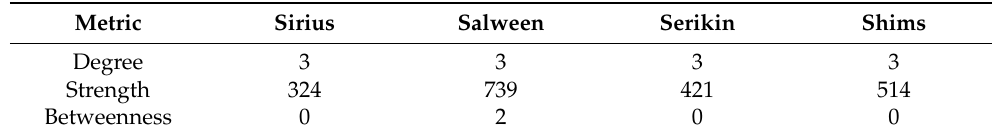
Table 4. Individual network metrics from the undirected network for the male (Sirius), female (Salween), and two cub tigers (Serikin and Shima) at Parc des F é lins. Metric Sirius Salween Serikin Shims Degree 3 3 3 3 Strength 324 739 421 514 Betweenness 0 2 0